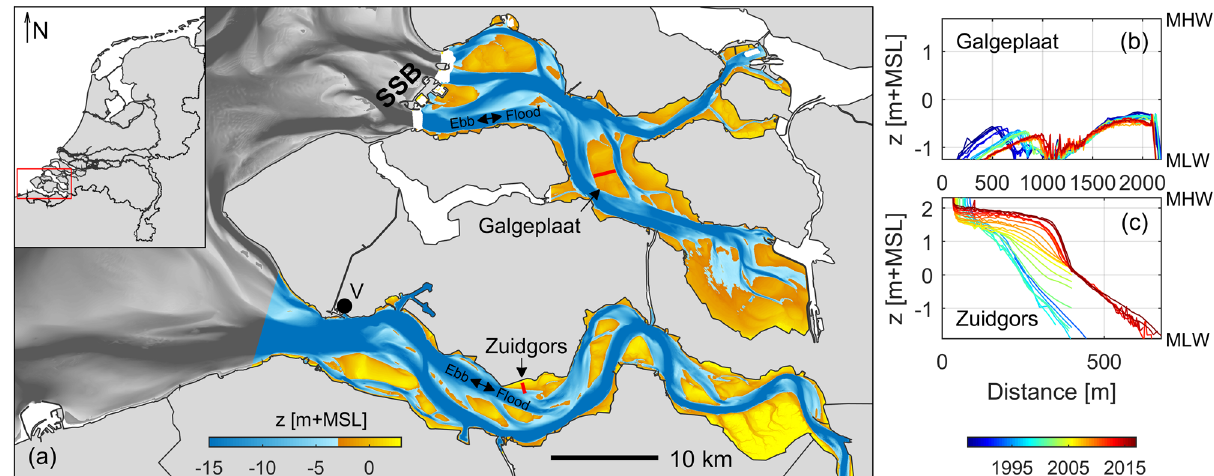
Figure 1. ( a ) Overview of the Eastern Scheldt (top estuary) with its storm surge barrier (SSB) and the Western Scheldt (bottom estuary), including their bathymetry. Both estuaries connect to the North Sea. The Zuidgors and Galgeplaat intertidal flats are indicated. The location of Vlissingen meteorological station (V) is indicated with the black marker. ( b , c ) The evolution of the red transects across the two intertidal flats over the past decades, vertically bounded between mean low water (MLW) and mean high water (MHW). All data is shown versus a fixed reference frame (the 2014 mean sea level;